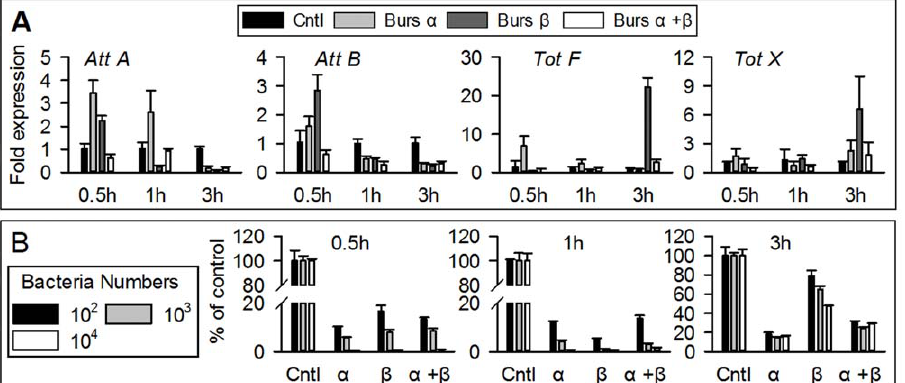
Figure 4. Burs a 2 a and burs b 2 b treatments induced expression of AMP genes and suppression of bacterial growth in larva FB. FB was dissected from early wondering 3 rd instar larvae and incubated with r-burs a 2 a or burs b 2 b homodimer or r-burs a + b heterodimer for 0.5, 1 and 3 h. The control group received the blank vector transfected sample. After incubation, RNA was extracted for qPCR analysis of 4 representative AMP genes (A). For bacterial inhibition assay, FB was homogenized and centrifuged at 16000 g for 20 min at 4 u C. The resulting supernatants were challenged with indicated titers of E. coli for 6 h before plating for colony count (B). The histograms show the means 6 SEM, n=3 biologically independent experiments.